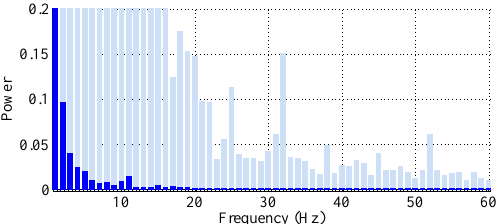
Figure 5. Power spectra of the magnitude of the three-axis accelerometer data each of the 100 balance and walking tests. The 200 densities are plotted on top of each other in order to see the maximum support that was observed at each frequency over all 200 tests. The shaded bars display the power spectra from the balance tests, and the colored bars denote the spectra of the walking tests. Since walking is highly periodic, in the spectra of these tests, most of the power is found in the lower frequencies associated with periodic walking. During the balance tests, periodic activities are observed for very short time durations, and the only periodic activity consistently recorded is the smartphone buzzer. This explains why we see that a lot of the power in the spectra is not found at the lower frequencies, but instead spread across the higher